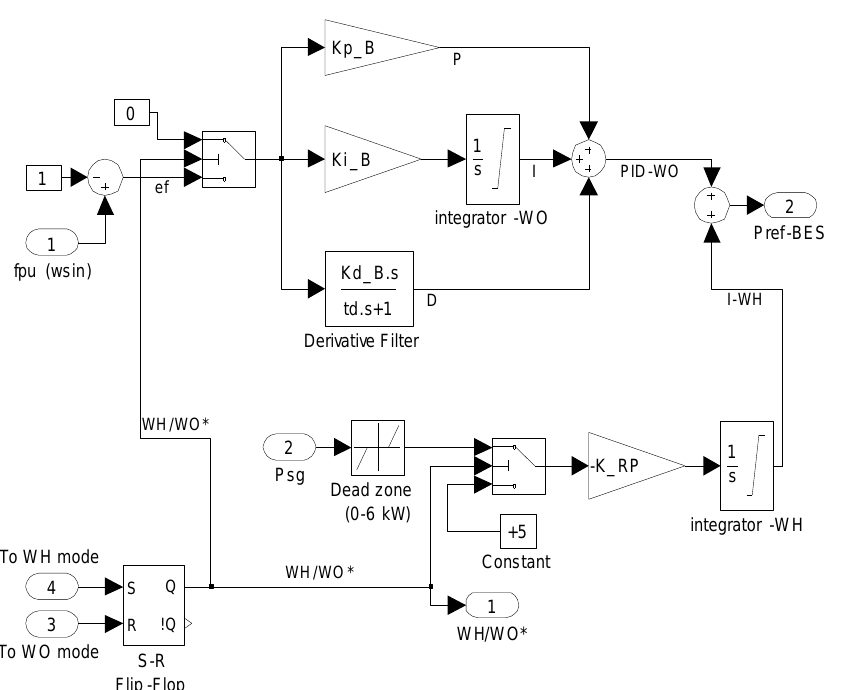
Figure 5. WH and WO modes Battery Energy Storage (BES) active power control Simulink sche- matic.